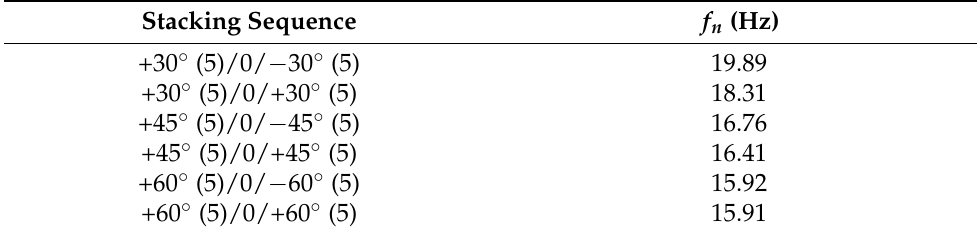
Table 3. The natural frequencies of the composite